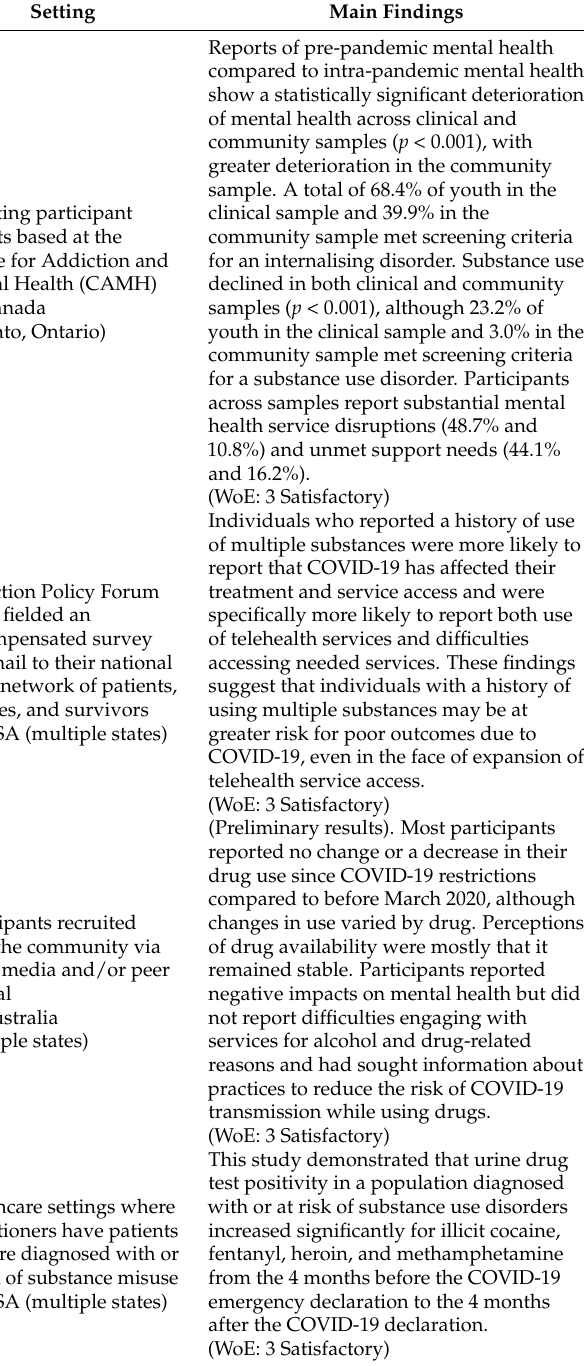
Table 8. People who use drugs/with diagnosis of Substance Use Disorder in predominantly community